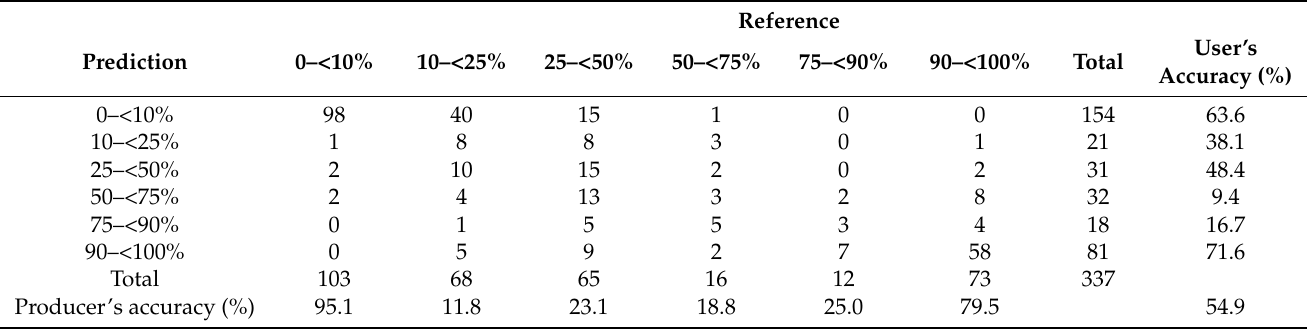
Table A14. Confusion matrix for current (Miller et al., 2009) model predicting IA canopy cover change with Landsat RdNBR with offset.